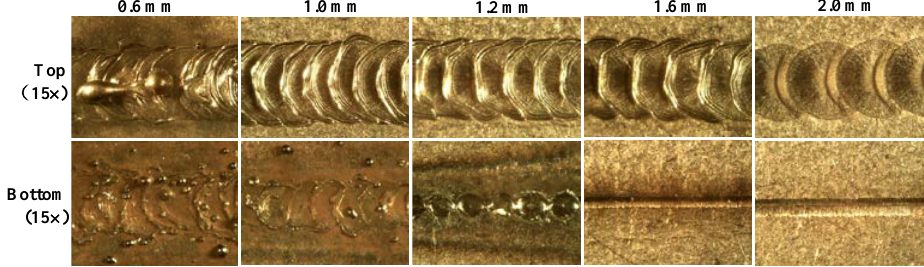
Figure 13. Comparison of weld surfaces under different spot diameters.